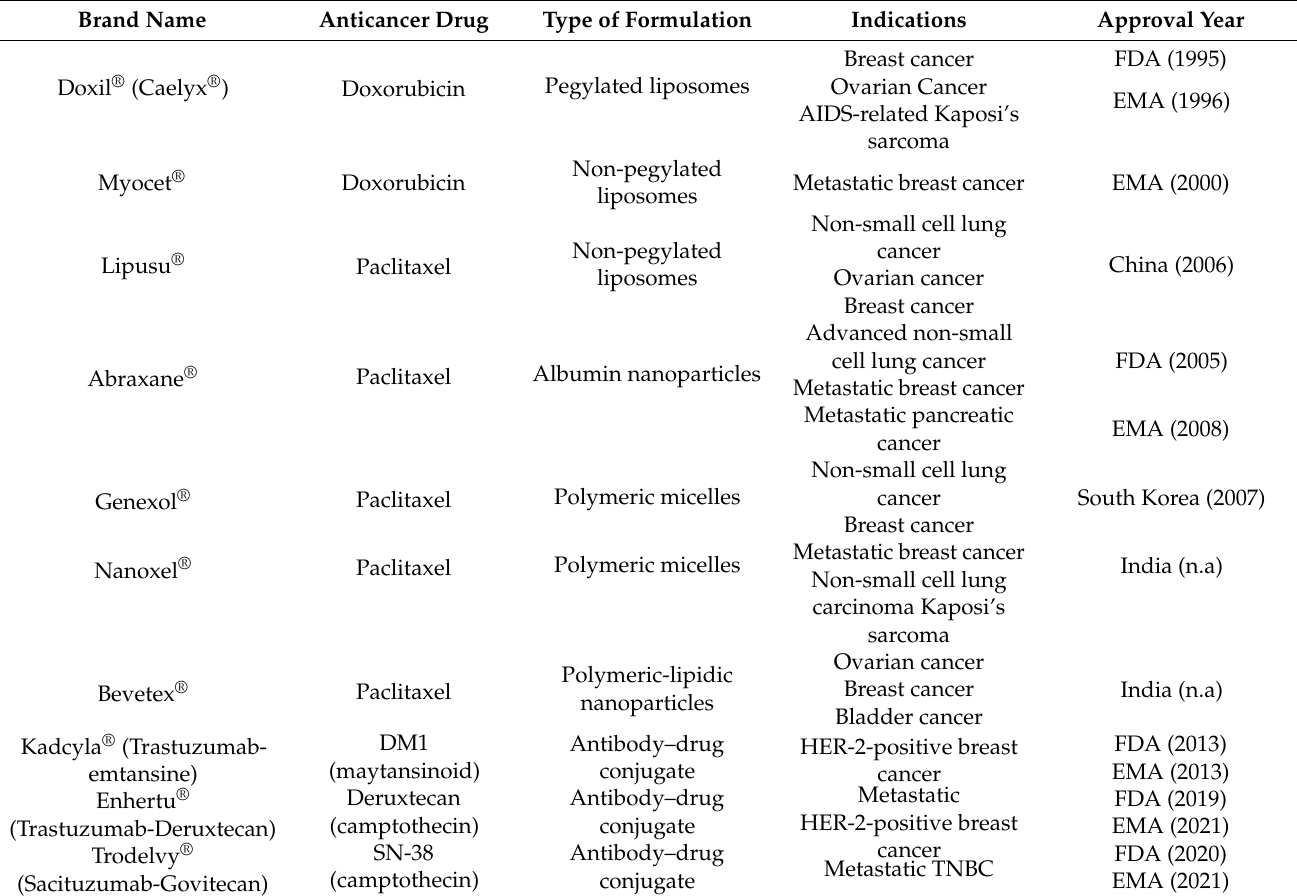
Table 1. Nanomedicines that are currently approved for breast cancer